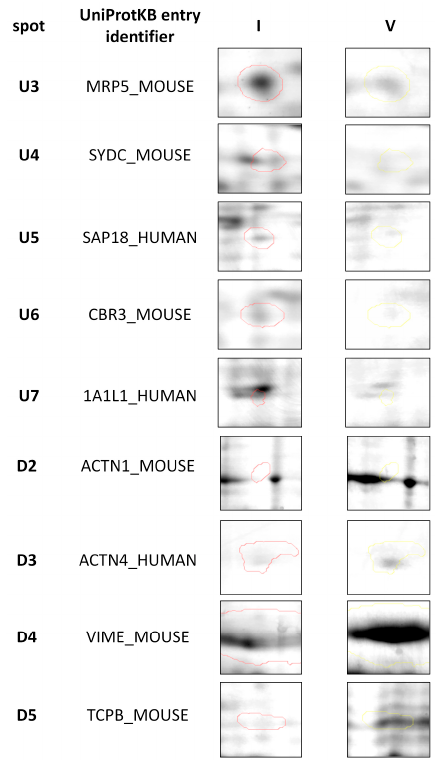
Figure 3. Representative two-dimensional electrophoresis gels of proteins that were significantly ( p ≤ 0.05) differentially expressed in feline fibrosarcomas from the FFS1 cell line versus the FFS5 cell line.